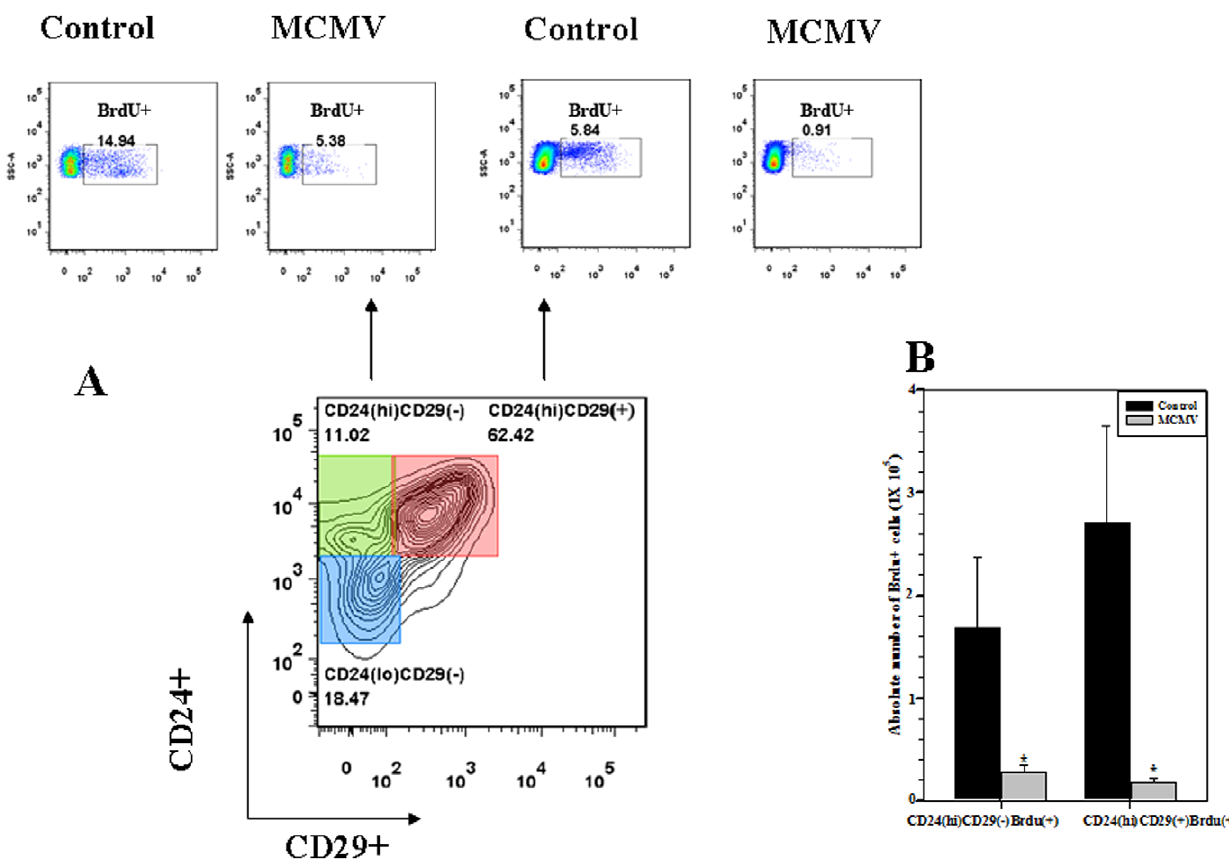
Figure 5. Reduced BrdU uptake by high CD24 expressing neuronal precursor cells in virus-infected brains. Mice were treated with BrdU on 7 d p.i. and 24 h later the brain samples were collected and processed for intranuclear BrdU staining as described in the methods. Cells were then analyzed by flow cytometry. A . Representative contour plot, gated on the CD45( 2 )CD15( 2 ) population showing the classification of cells (lower panel) and the ratio of BrdU + cells among the respective cell types is shown (upper panel). B . The absolute numbers of BrdU + cells within each subtype, obtained from infected brains versus control brains are shown. Data were derived from 3 independent experiments, n=3–5 neonates. * p , 0.05 versus mock infected.